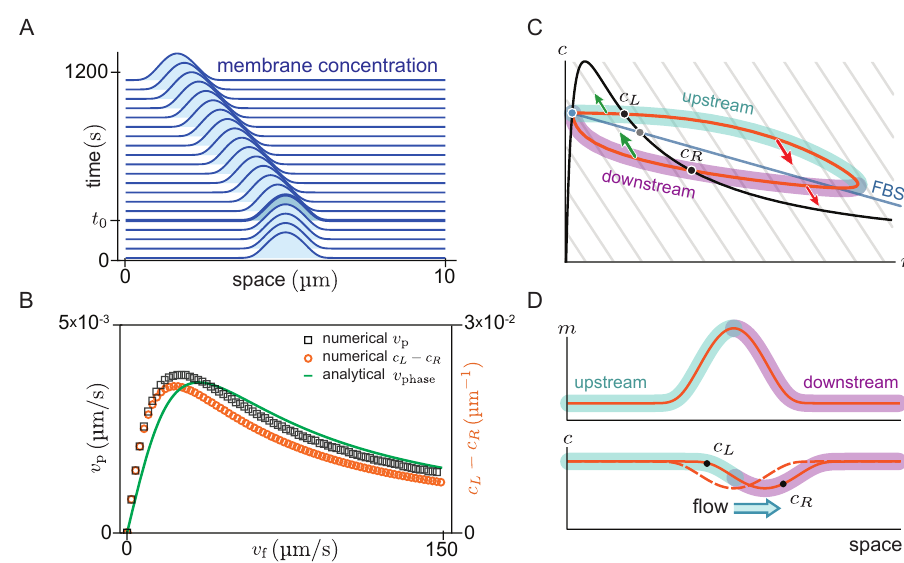
Figure 4. Pattern dynamics far from the spatially homogeneous steady state. ( A ) Time evolution of the membrane-bound protein concentration. At time t 0 = 240s a constant cytosolic flow with velocity v f = 20µm/s towards the right is switched on (cf. Supplementary Materials Movie 3). ( B ) Relation between the peak speed ( v p ) and flow speed ( v f ). Results from finite element simulations (black open squares) are compared to the phase velocity of the mode q max obtained from linear stability analysis (green solid line) and to an approximation (orange open circles) of the area enclosed by the density distribution trajectory in phase space (area enclosed by the ‘loop’ in D ). (The domain size, L = 10µm, is chosen large enough compared to the peak width such that boundary effects are negligible.) ( C ) A schematic of the phase portrait corresponding to the pattern in D . The density distribution in the absence of flow is embedded in the flux-balance subspace (FBS) (blue straight line). In the presence of flow, the density distribution trajectory forms a ‘loop’ in phase space. The upstream and downstream side of the pattern are highlighted in cyan and magenta, respectively. Red and green arrows indicate the direction of the reactive flow in the attachment and detachment zones, respectively. At intersection points of the density distribution with the nullcline ( c L and c R ) the system is at its local reactive equilibrium. ( D ) Sketch of the membrane (orange solid line, top) and cytosolic (orange dashed line, bottom) concentration profiles for a stationary pattern in the absence of cytosolic flow. Flow shifts the cytosol profile downstream (orange solid line,